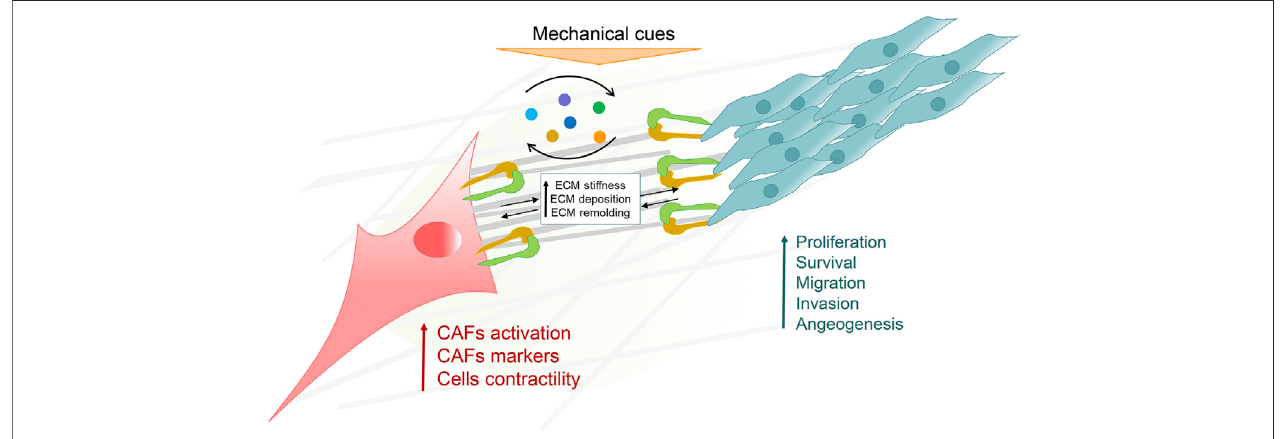
FIGURE2| The crosstalkofcancerassociated fi broblasts (CAFs) andthecancermicroenvironment (CME).CAFsand cancercells areresponsiblefor sensingand transducing various extracellular matrix (ECM) proteins and mechanical signals in the CME. CAFs and cancer cells also effect each other ’ s physiological processes by releasing and receiving various factors in a paracrine